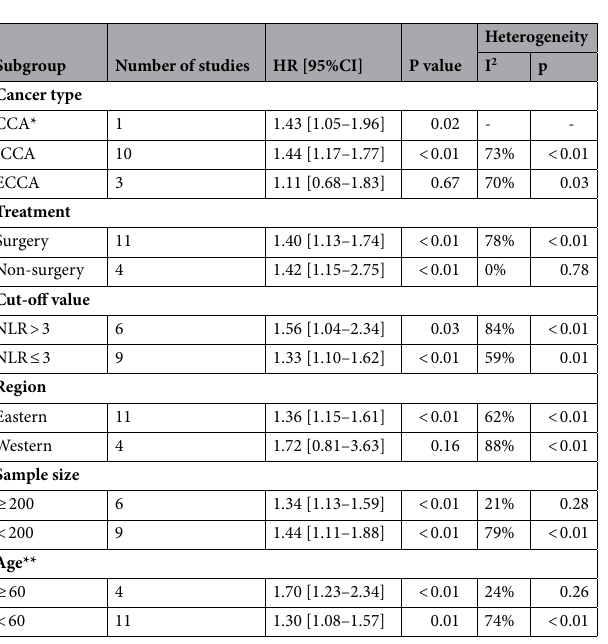
Table 4. Summary of the subgroup analyses of the correlation between NLR and DFS in CCA patients. *Includes both ICCA and ECCA. **Mean/median age of the study cohort. ECCA extrahepatic cholangiocarcinoma, HR hazard ratio, ICCA intrahepatic cholangiocarcinoma, NLR neutrophil-to-lymphocyte